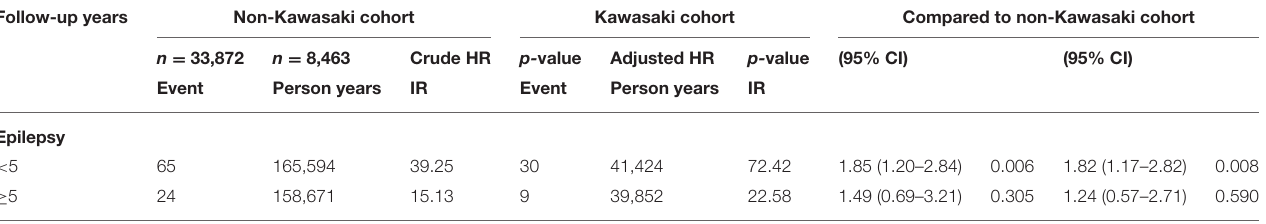
TABLE 4 | Incidence rates, hazard ratio, and confidence intervals of epilepsy in different follow-up stratification. Follow-up